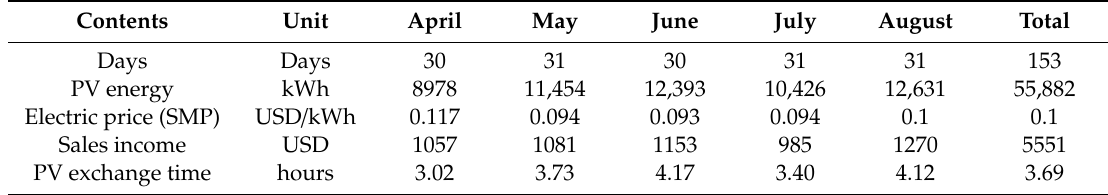
Figure 14. Transparent-panel specification (Section F).